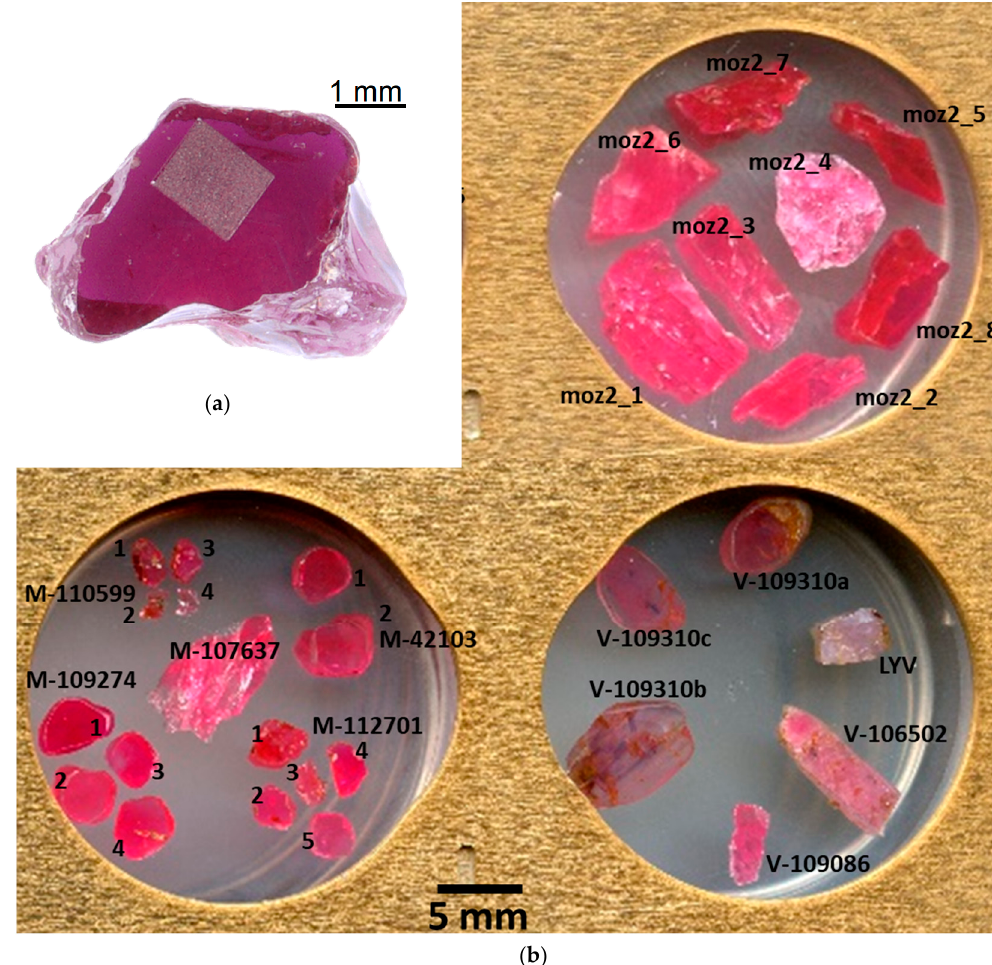
Figure A2. ( a ) Ruby from Zahamena, MDG after ablation clearly demonstrating the size of the offline ablation pit. ( b ) One inch resin sample mounts for LA-ICP-MS analysis showing rubies from Mozambique (moz), Myanmar (M-xxx), and Vietnam (V-xxx). A range of color and clarity is shown by these rubies.